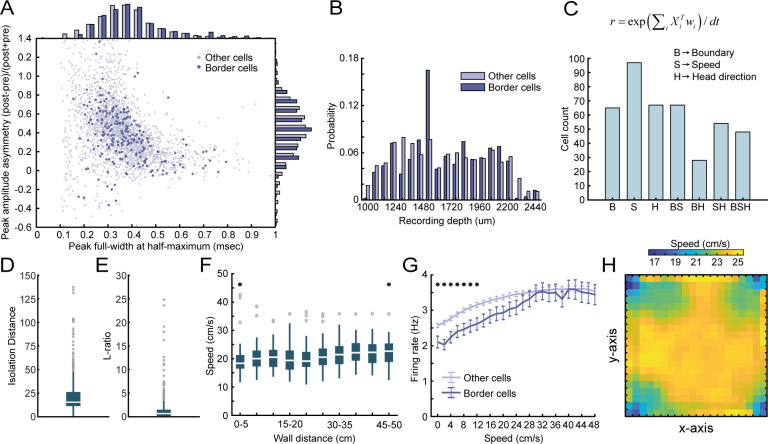
The dissociation between the animal’s running speed and activity around borders.(A) Waveform properties of RSC border cells versus other cells recorded on the same tetrodes show no major difference between both populations. (B) Border cells were recorded both in granular and dysgranular layers of RSC across the recording depths. (C) An unbiased classification approach was applied based on linear-nonlinear models (Hardcastle et al., 2017). Three variables, Xi, were included: B, a one-dimensional vector of distance to the closest boundary, S, the animal’s running speed, and H, the animal’s allocentric head-direction. Models were built with increasing complexity using a forward-search approach (e.g., starting with one variable, then adding more if the model’s performance increases significantly, tested using ten-fold cross-validation). The model that best explained (e.g., had maximal log-likelihood) the cell’s firing rate, r, using optimal weights, wi, was then selected. Results show that boundary, speed, and head-direction encoding in RSC are independent features, as they can be expressed in isolation, combined with a substantial number of neurons that display conjunctive coding. (D-E) Tetrode cluster quality metrics that quantify the isolation distance (median = 15.39, IQR = 11.26–26.26) and L-ratio (median = 0.67, IQR = 0.17–1.51), based on Kilosort single vector decomposition (SVD) factor loadings (Schmitzer-Torbert et al., 2005). (F) There was no bias in the animal’s behavior around walls, as the running speed of the animals was uniformly distributed as a function of distance to the closest wall. (G) Both border cells and other cells recorded in RSC are modulated by running speed, with a ramping of firing rates as the running speed increases. However, border cells further showed lower firing rates in the low-speed range compared to other recorded cells. (H) Speed of the animal was uniformly distributed across the 2D space of the arena. *p<0.05, Wilcoxon signed-rank test (D), Wilcoxon ranksum test (E).